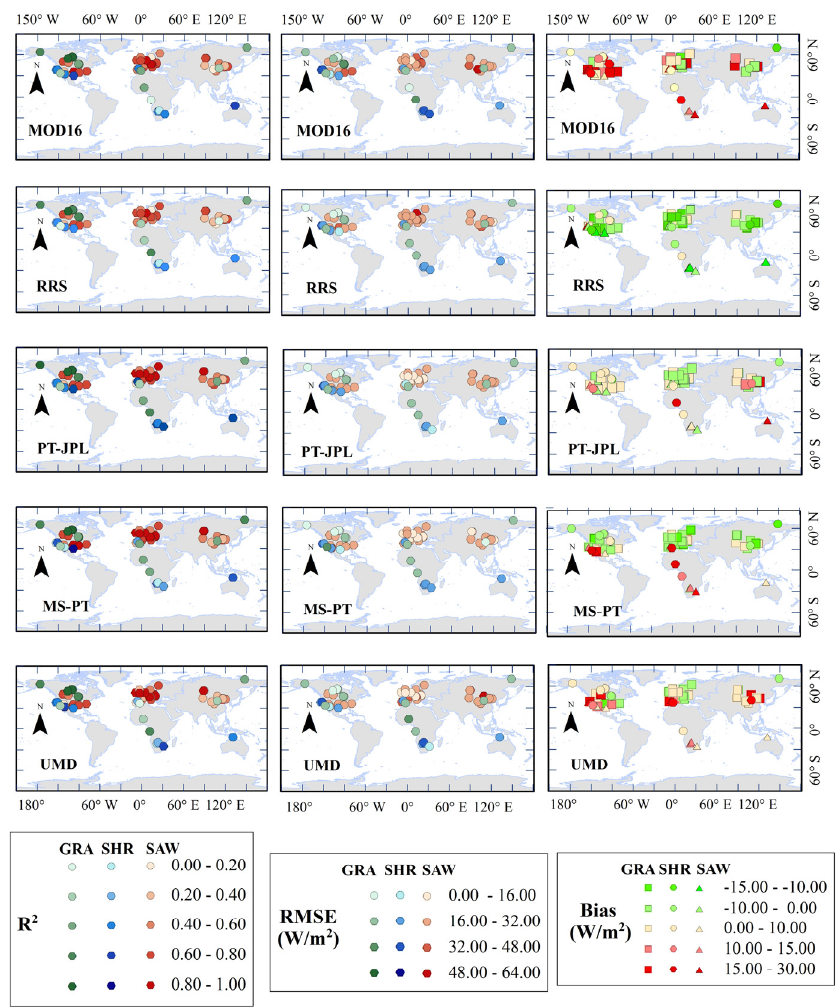
Figure 7. Spatial distribution of the correlation coefficients, RMSE and Bias for estimated daily LE calculated by MOD16, RRS, PT-JPL, MS-PT, and UMD over the period 2000–2009.